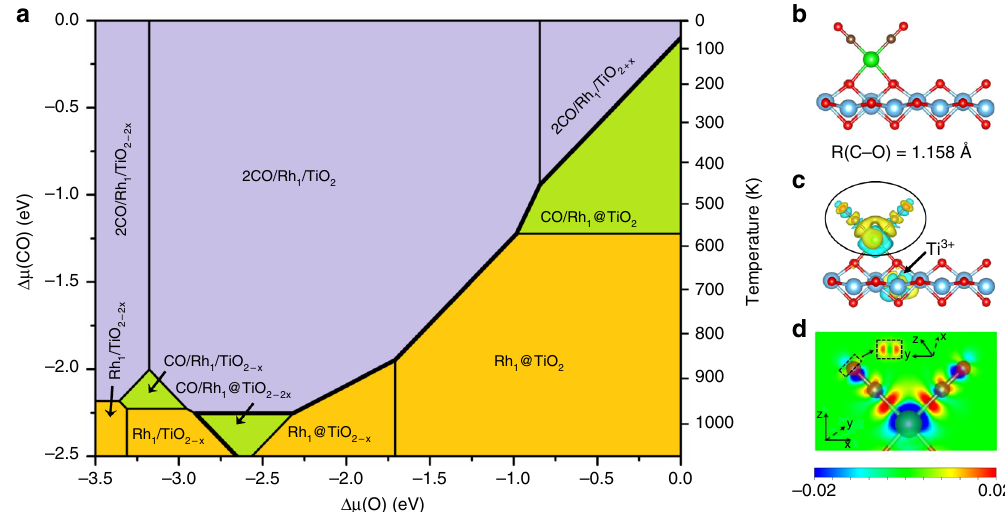
Fig. 4 Structure and stability Of Rh single atom in the presence of CO. a Surface stability diagram for Rh single atom on TiO 2 (110) as a function of CO and O chemical potentials. Colors indicate the different number of CO molecules adsorbed on Rh 1 TiO 2 , where orange, green, and purple represent the 0CO, 1CO, and 2CO, respectively. The temperature in right axis corresponds to the Δ μ (CO) in left axis with 0.1 atom CO. b Local environment of Rh 1 /TiO 2 in the presence of CO. c , d 3D ( c ) and 2D ( d ) representations of the charge density difference between 2CO/Rh 1 /TiO 2 and Rh 1 /TiO 2 , show the donation and back-donation electron